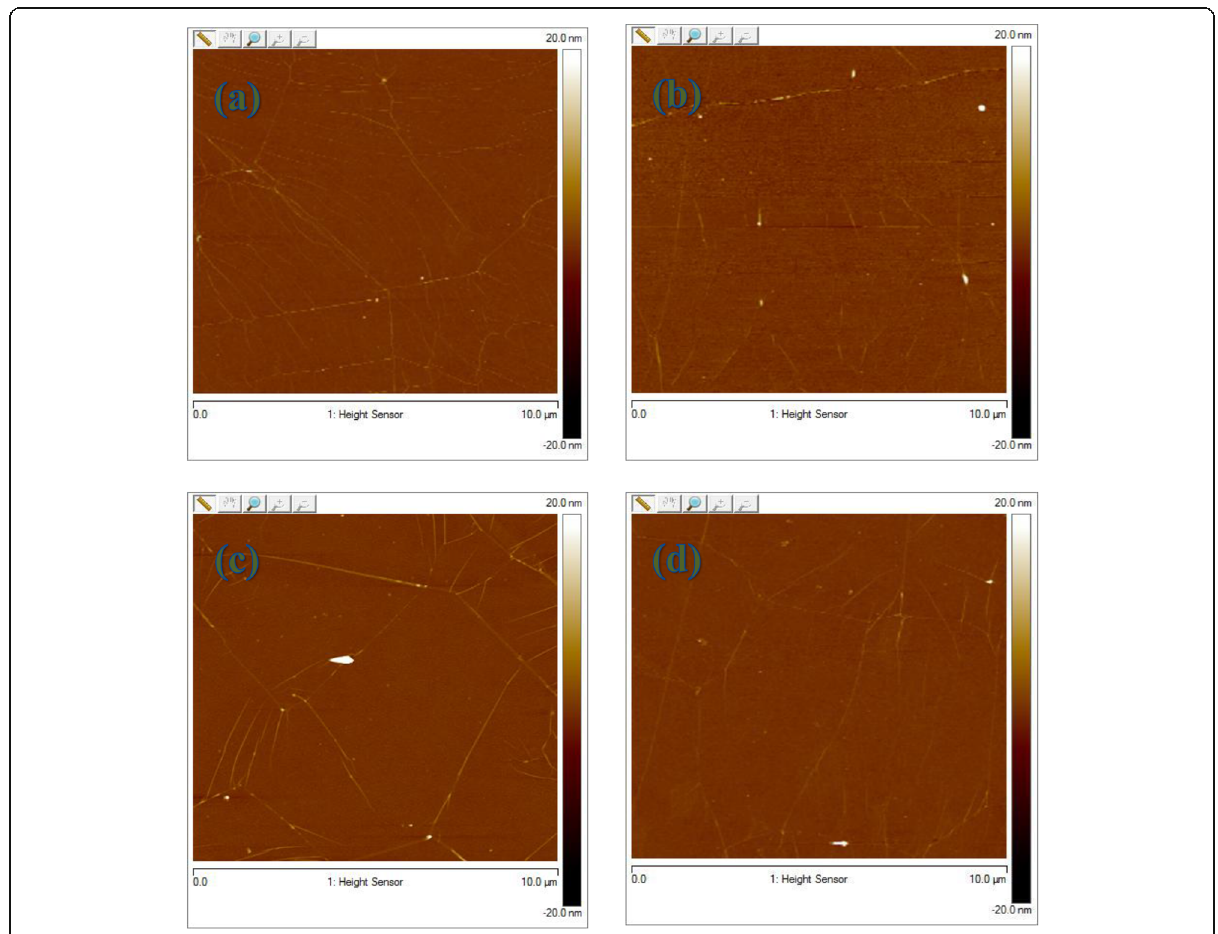
Fig. 4 AFM spectrum of a anisole/rosin/graphene coated transfer at room temperature (RMS = 0.523 nm) and b – d anisole/rosin/graphene sample baked at 100 °C (RMS = 0.887 nm), 150 °C (RMS = 0.950 nm), and 200 °C (RMS = 0.98 nm),